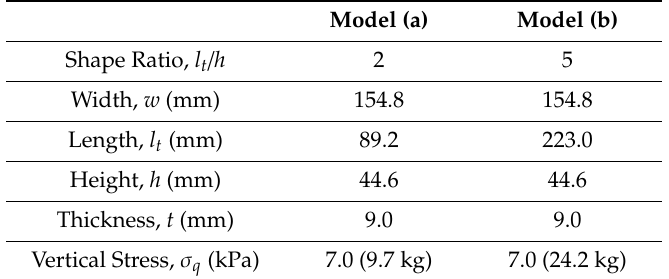
Table 4. Material properties of model track systems used for the verification